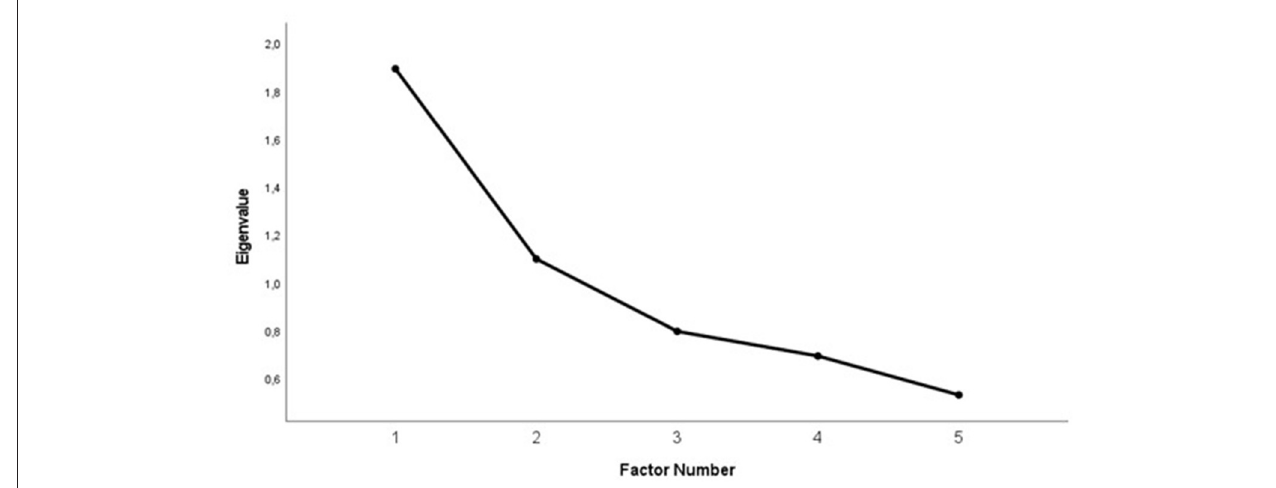
FIGURE 1 | NEO-FFI trait-analysis. Component scree plot.